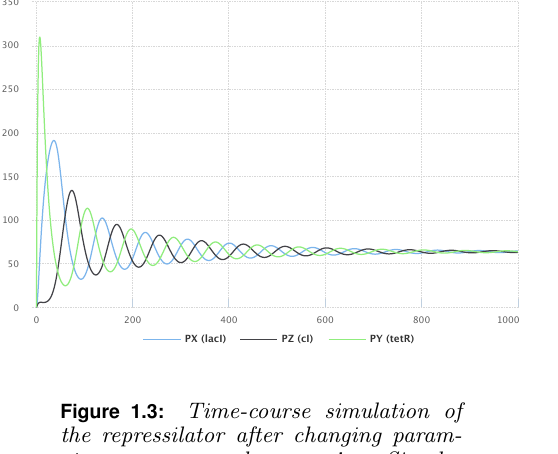
Figure 1.3: Time-course simulation of the repressilator after changing param- eters tps repr and tps active . Simula- tion with SED-ML web tools [2].